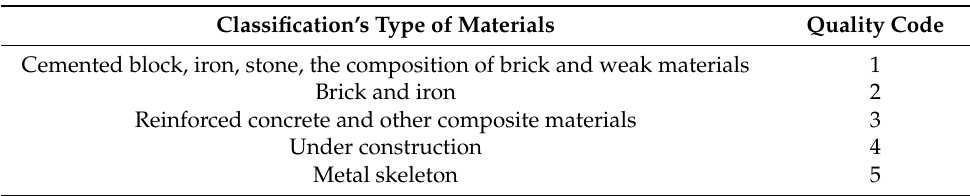
Table 4. Rating type of building’s materials.